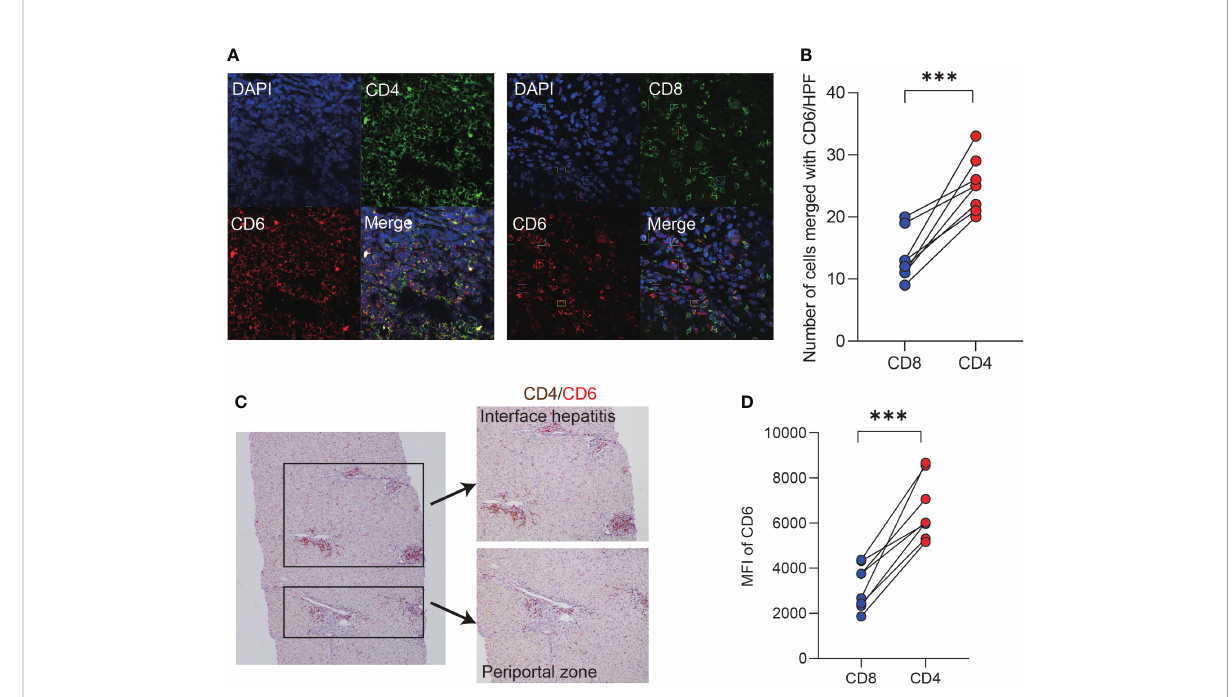
FIGURE 2 CD6 was mainly expressed on CD4 + T cells in AIH liver. (A, B) Representative confocal images and quanti fi cation analysis of CD4 + CD6 + , CD8 + CD6 + cells using human liver biopsies from patients with AIH (n=8). (C) Representative dual-color immunohistochemistry images of CD4 (brown) and CD6 (red) using human liver biopsies from patients with AIH (n=10). (D) The expression of CD6 on CD4 + and CD8 + T cells of liver- in fi ltrating cells from explanted liver of AIH was analyzed by fl ow cytometry (n=8). MFI, mean fl uorescent intensity, ***p <